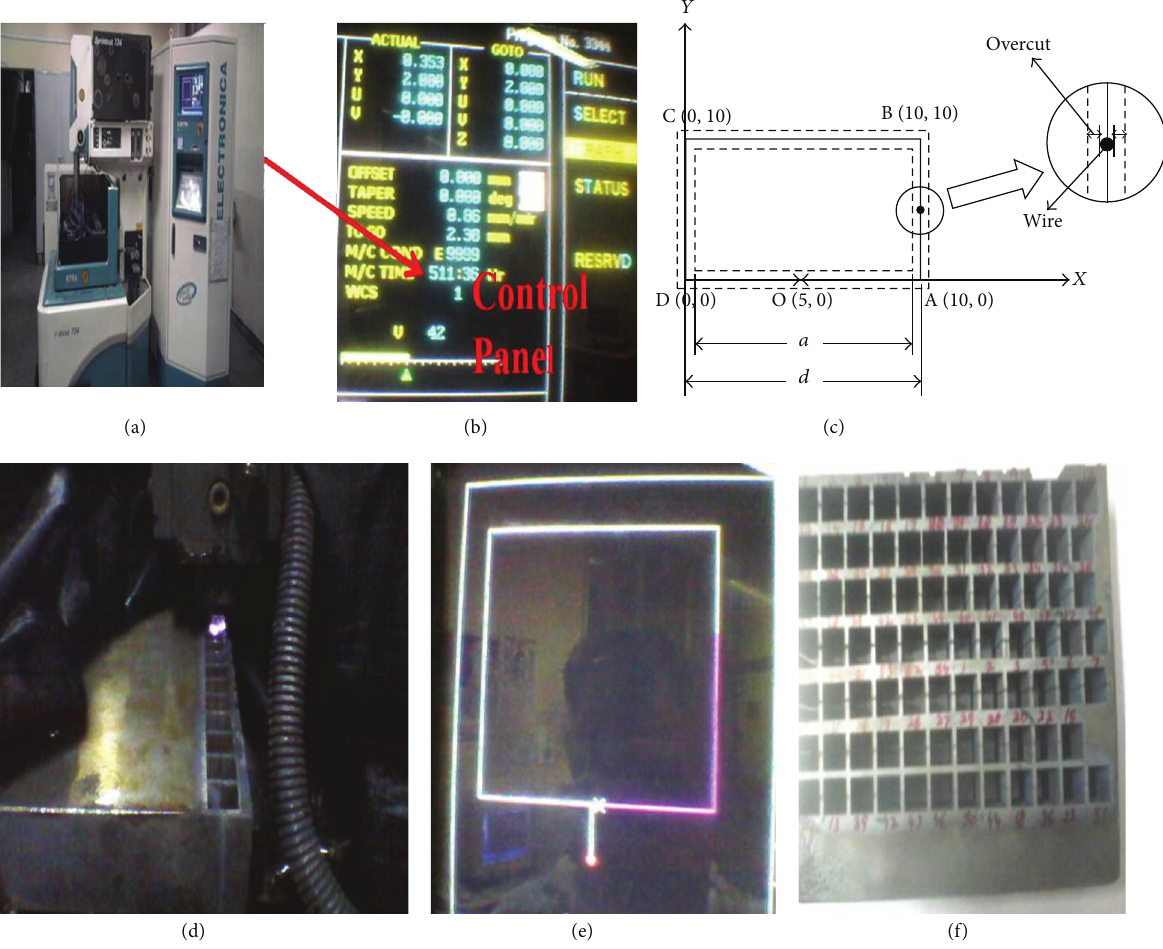
Figure 1: Job profile and experimental setup of WEDM machine tool (a) 4-axis WEDM CNC type, machine tool, (b) machine control panel, (c) work-path profile, (d) wire (tool) and workpiece (e) wire path on control panel, (f) square punch produced after